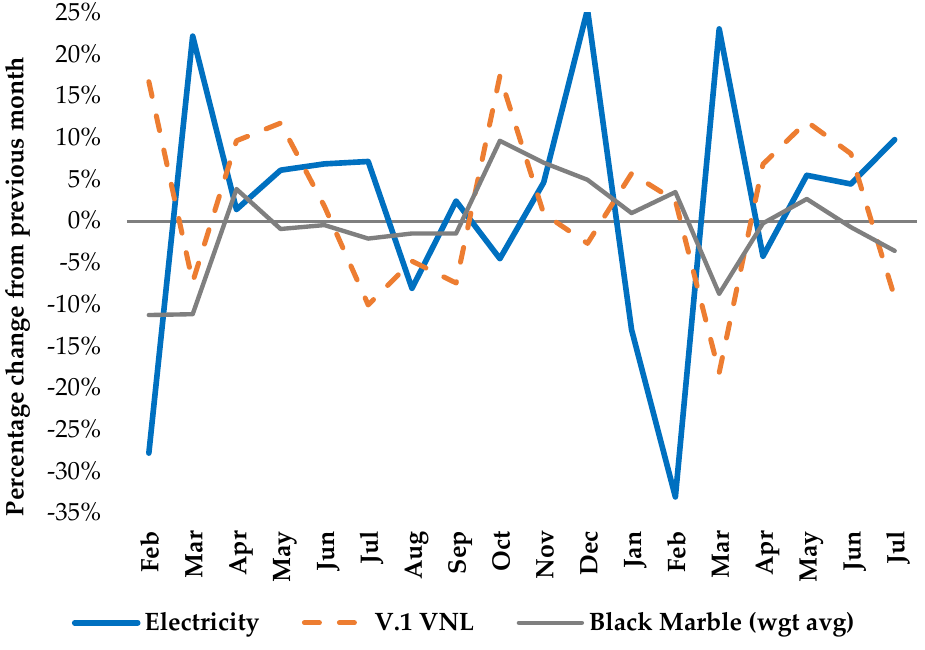
Figure 4. Monthly changes in China’s electricity use and NTL composites: 202 0 − 21.